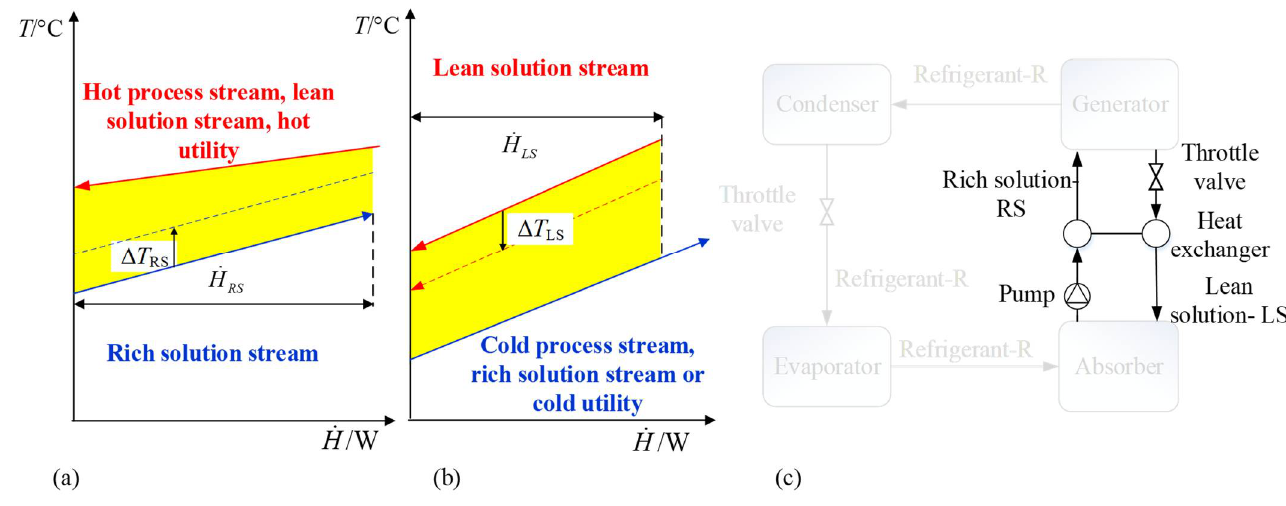
Figure 4. Heat integration of ( a ) rich and ( b ) lean solution represented by composite curve and ( c ) presentation of both, rich and lean, as a part of AC cycle.